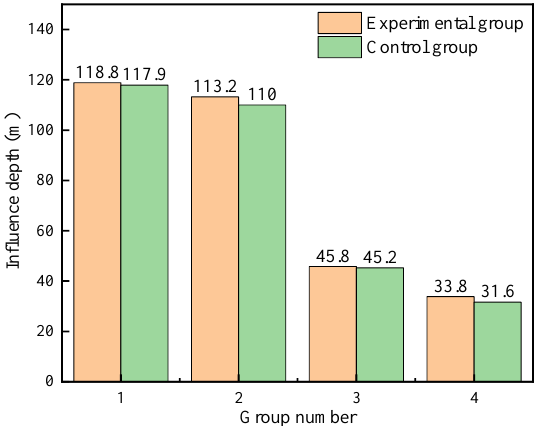
Figure 12. Comparison of the influence depth of gas mass fraction in the strike direction between the experimental and the control groups.